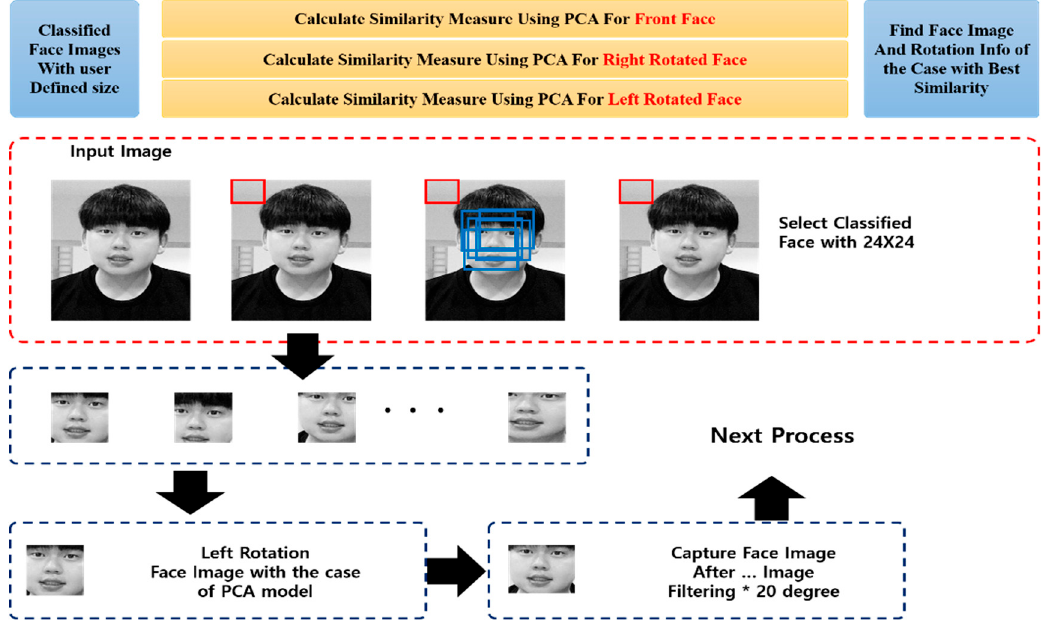
Figure 7. The face image detection process. * The figure included in this image is the author, who agreed to provide the figure.